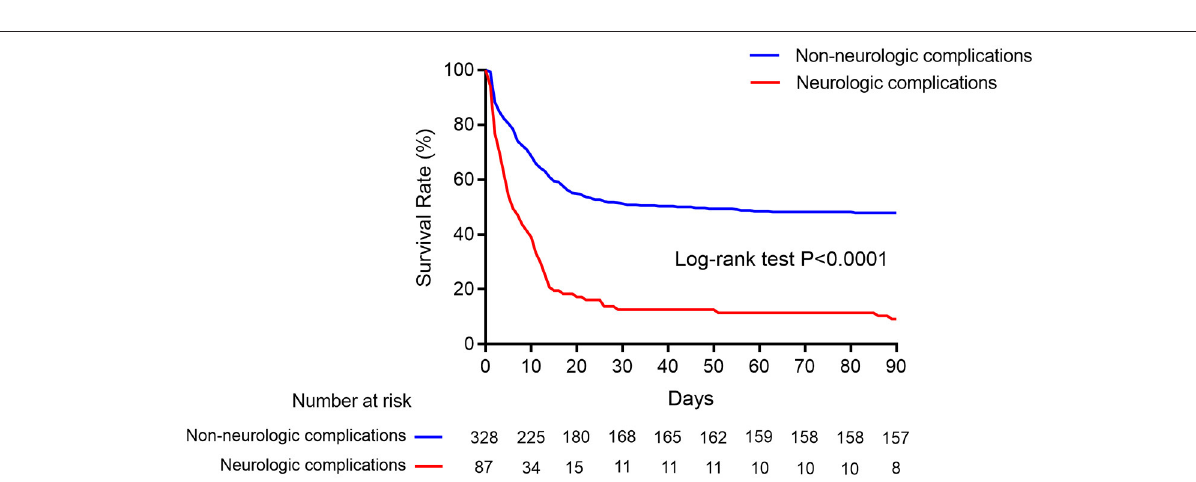
The rate of successful weaning from ECMO (35.6 vs.